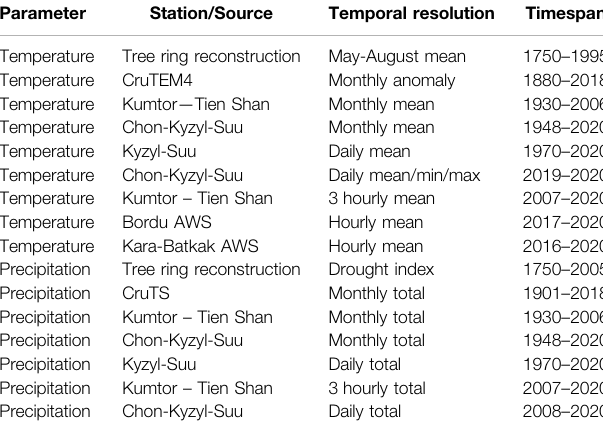
TABLE 1 | Temperature and precipitation datasets and timespans included in this study. Kumtor-Tien Shan, Chon-Kyzyl-Suu and Kyzyl-Suu are three (automatic) weather